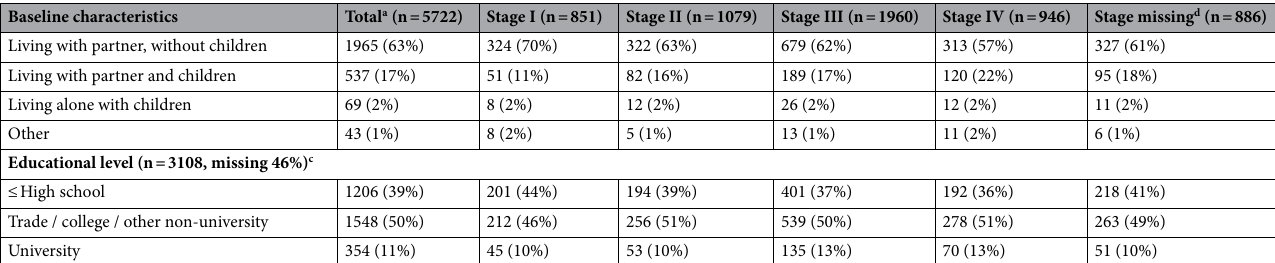
Table 1. Baseline descriptive demographic and clinical characteristics at PLCRC enrollment, stratified by tumor stage. Descriptives are presented as count (%), mean (± SD), or median (IQR). a N = 22 patients with permanently unknown tumor stage are not included in the analysis. b In case of missing data, the descriptive statistics of complete cases are presented. c Self-reported. d PLCRC is a dynamic cohort with continuous new enrollment and data-linkage. The high percentage of missing data, is due to the time-lag between enrollment and data linkage from the NCR to PLCRC, which is continuously